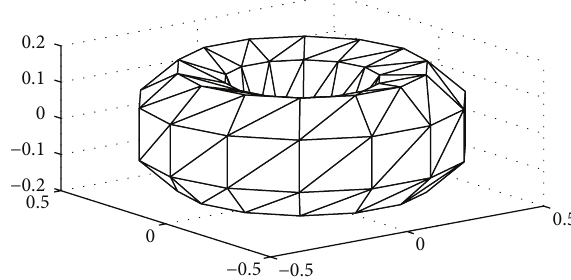
Figure 6: Illustration of the triangular-cell torus models used in the analysis. This model contains 196 flat cells.